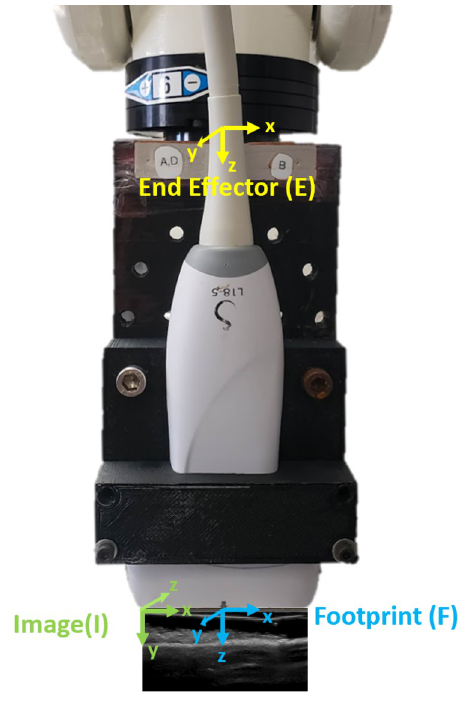
Fig 2. Coordinate systems. The end-effector, image, and footprint coordinate systems rigidly fixed to the end effector of the six-degree of freedom robot arm.